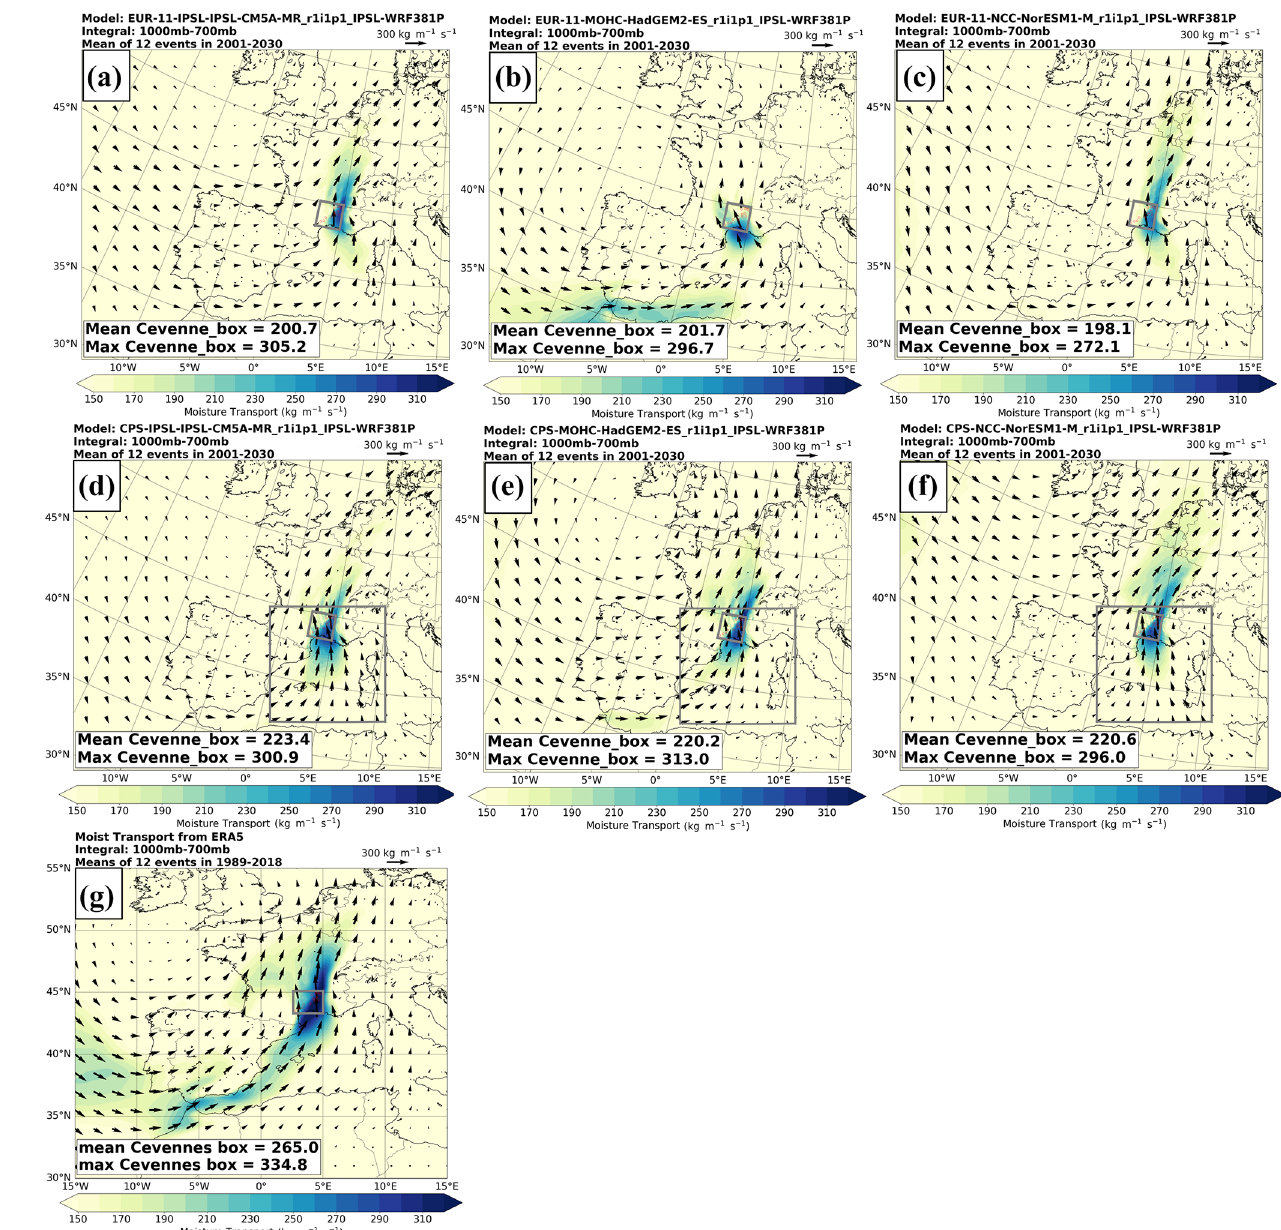
Figure 7. Mean moisture transport of the 12 heaviest daily rainfall events from all simulations (2001–2030, from a to c for EUR-11 simulations and from d to f for CPSs) and ERA5 (1989–2018, panel g ). Note that the domain of CPS is far smaller to meet the requirement of these analyses. Therefore, we embedded each CPS moisture transport inside its corresponding driving EUR-11 for the same 12 events of that CPS. This means that results from EUR-11 in these cases (d–f) may differ from those in panels (a) – (c)